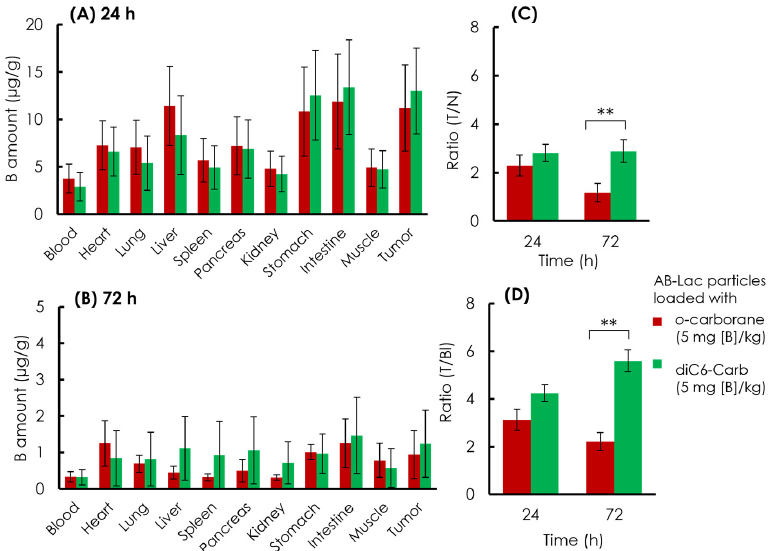
Figure 8. Ex vivo B biodistribution of the AB-Lac particles loaded with B compounds. B amount in tumor lesions at 24 h ( A ) and 72 h ( B ); T/N ratio ( C ) and ( D ) T/Bl ratio at 24 and 72 h. Data are expressed as mean ± S.E.M. ( n = 4). Significant differences are represented by ** p < 0.05.